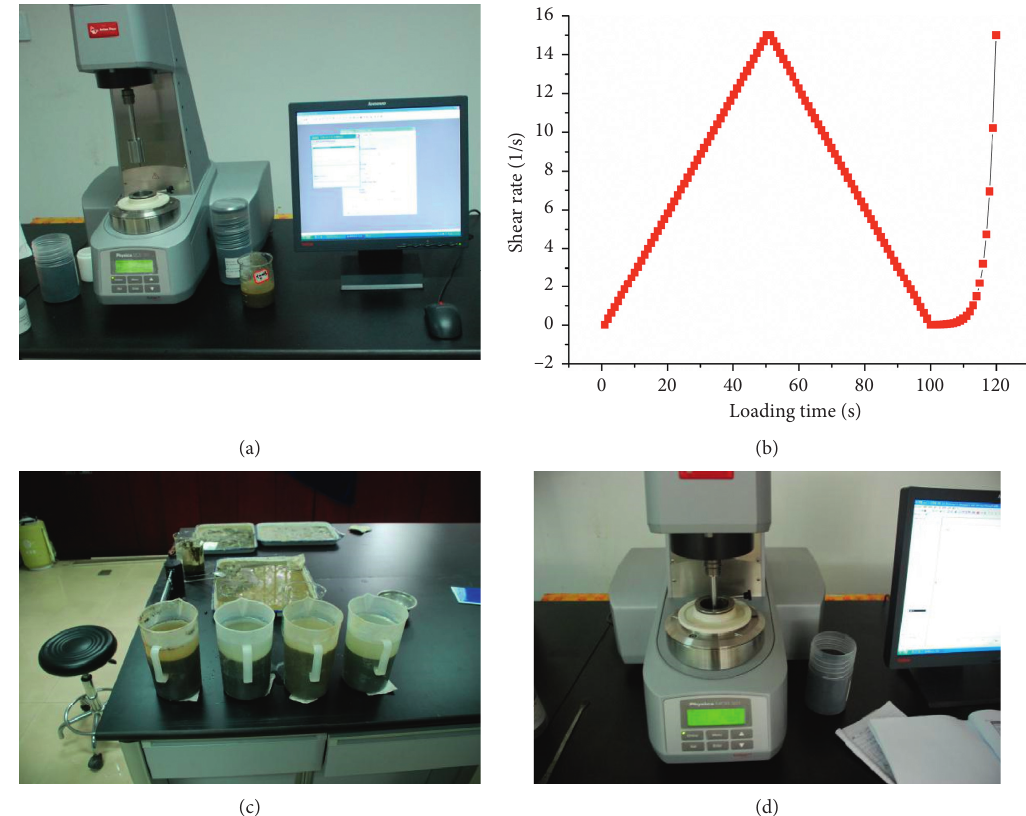
Figure 4: Rheological experiment instrument and process. (a) Physica MCR301. (b) Experimental loading process. (c) Rheological test sample. (d) Rheological experiment in progress.